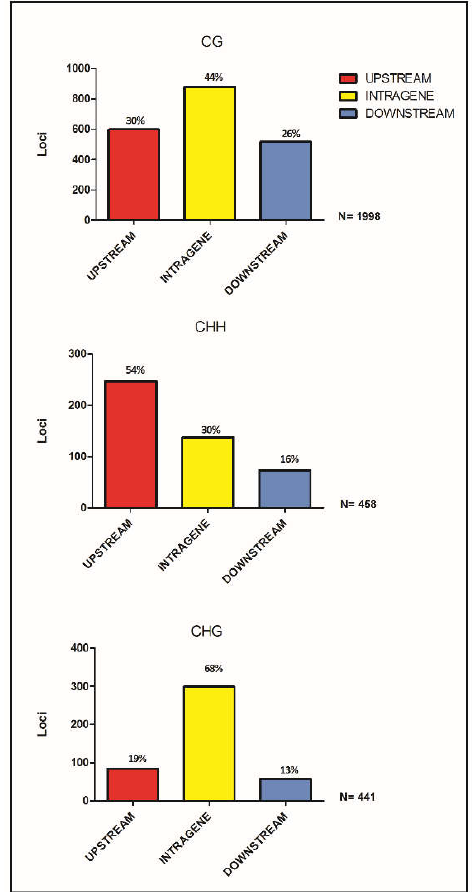
Figure 3. Genome-wide distribution of DML. Different localization of differentially methylated loci in the three contexts of methylation is highlighted in the bar plots. N is the library-specific number of DML obtained in the bioinformatics analysis. Upstream regions are identified in a window of 2,000 bp upstream the translational start (start codon), intragenic regions overlap with coding DNA sequence (CDS), downstream regions refer to a window of 2,000 bp downstream the translational stop (stop codon).